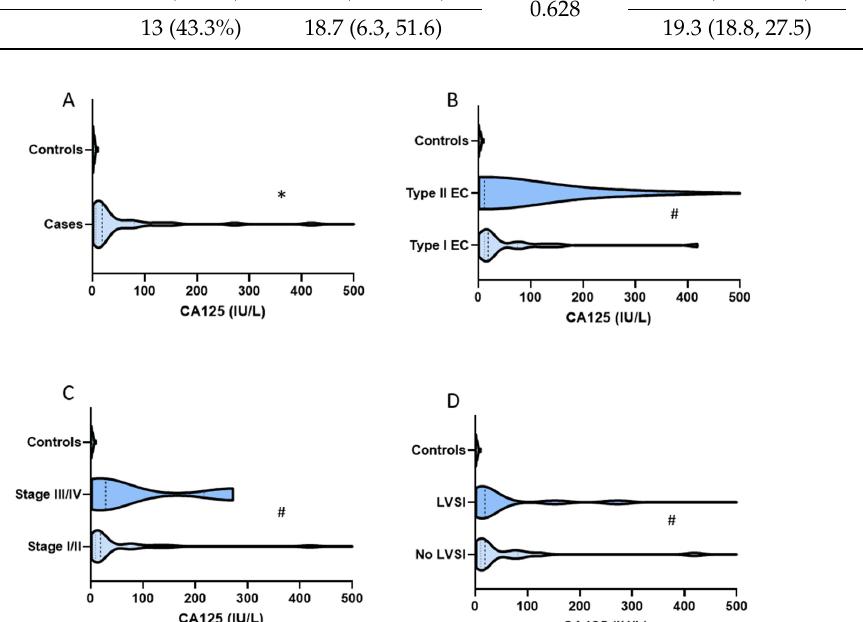
Figure 2. Violin plots comparing ( A ) urine CA125 by case-control status, ( B ) Bokhman group, ( C ) cancer stage, and ( D ) absence or presence of lymphovascular space invasion. Statistical significance was determined by the nonparametric Mann–Whitney U tests for relevant dichotomous groups. The p -values portrayed with * indicate p < 0.05 while # indicates p > 0.05.